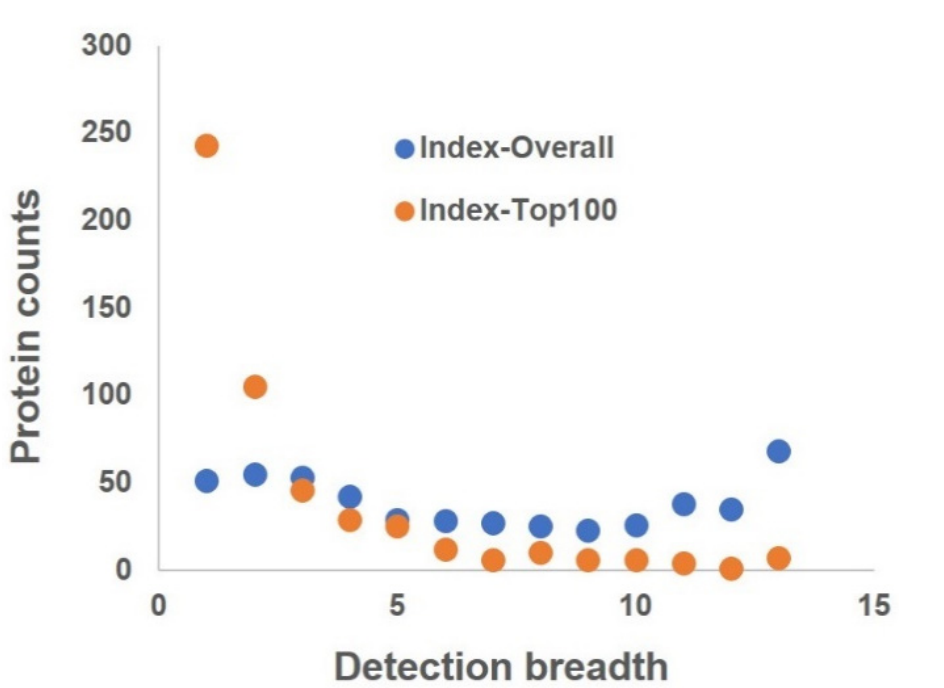
Figure 3. Protein distribution as a function of detection breadth in the organ proteomes, in which the Index-Overall represents the frequency a protein was detected in the overall panorgan proteome, and Index-Top100 represents the frequency a protein was in the panorgan proteomes of top100 proteins. The conditional OSPs obtained from top100 proteins were compared with vOSPs and cOSPs obtained from the overall proteomes. Clear distinctions exist. First, conditional OSPs are much more abundant in measured quantity than vOSPs and cOSPs